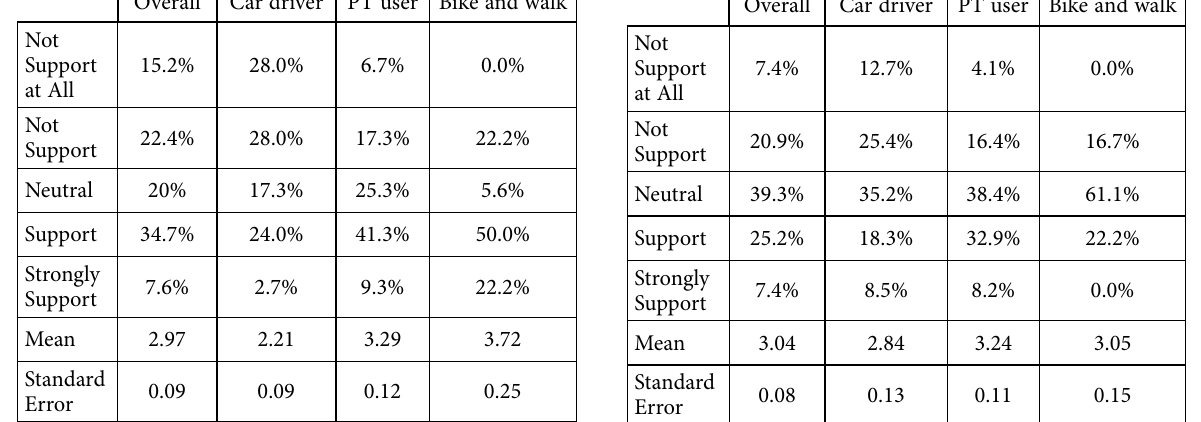
Table 7. Public acceptance rate on existing highway tolls Overall Car driver PT user Bike and